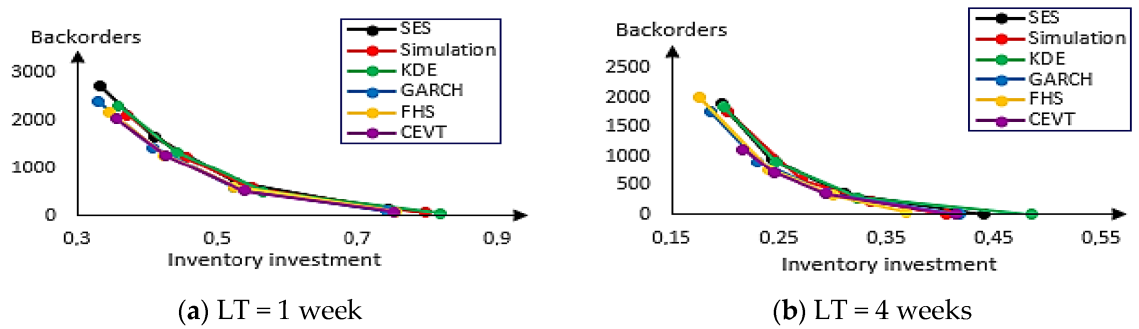
Figure 11. Backorders of each method for real demand that follows ARMA-GARCH model for one week ( a ) and for four weeks ( b